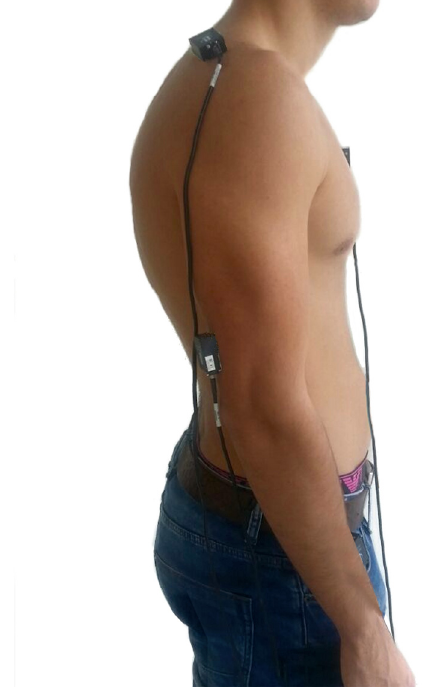
Figure 1. Inertial sensors’ placement.